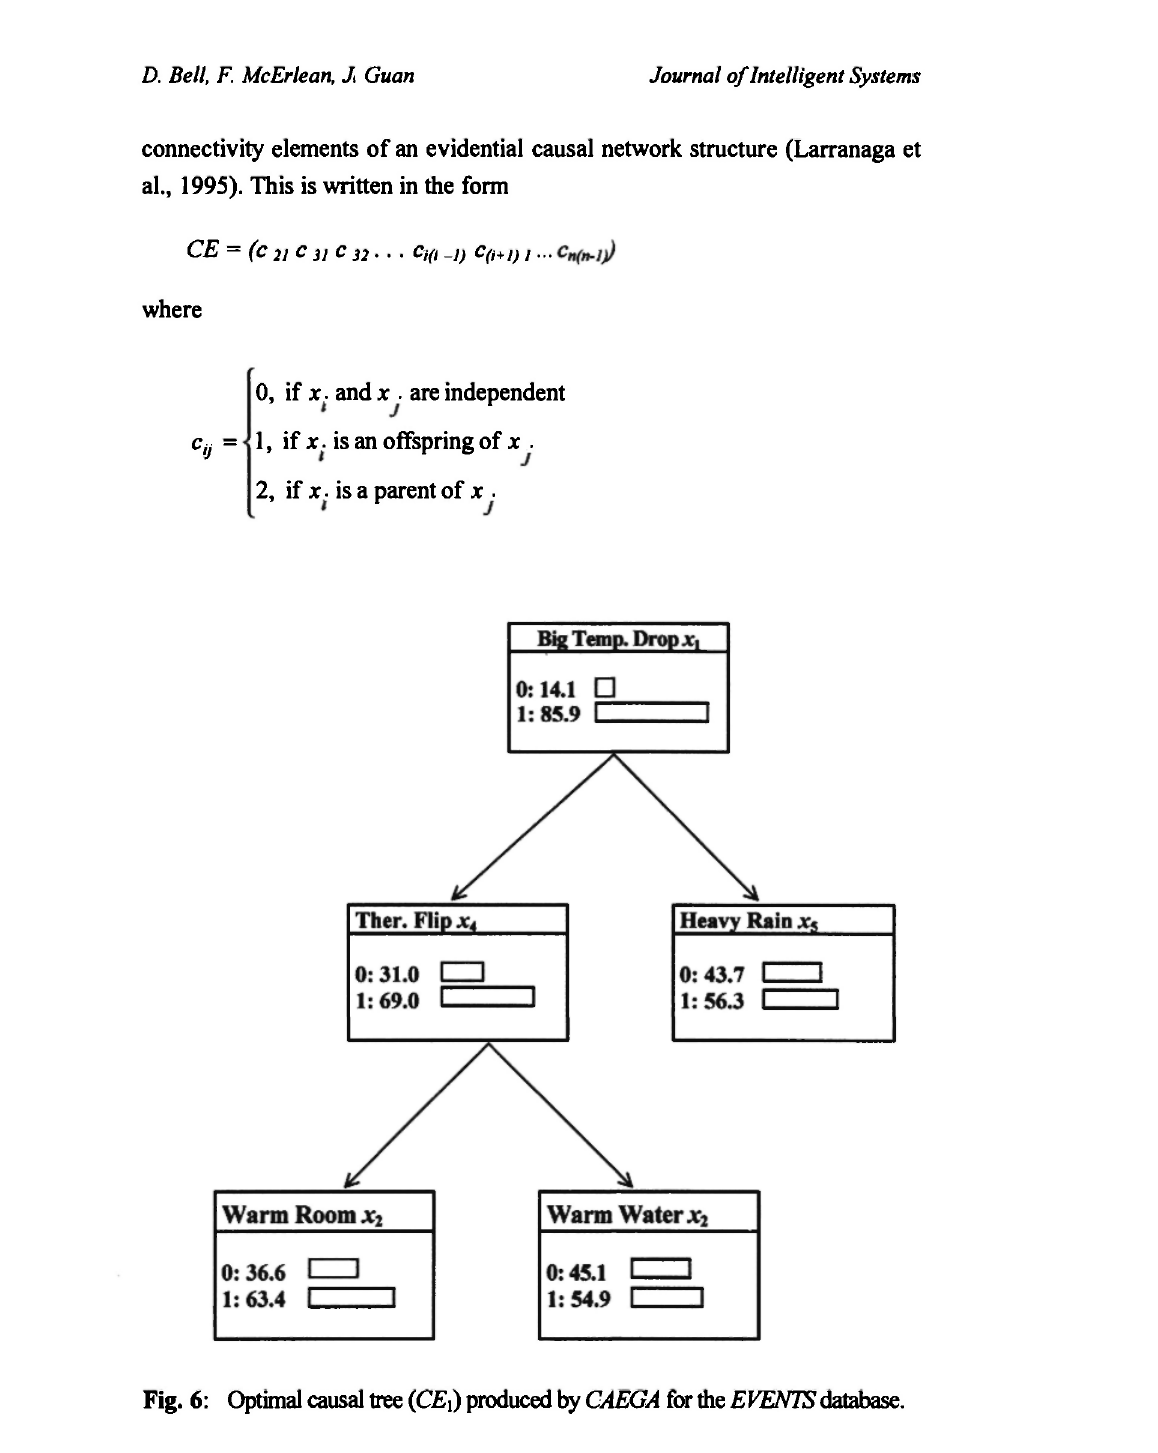
Fig. 6: Optimal causal tree (C£,) produced by CAEGA for the EVENTS